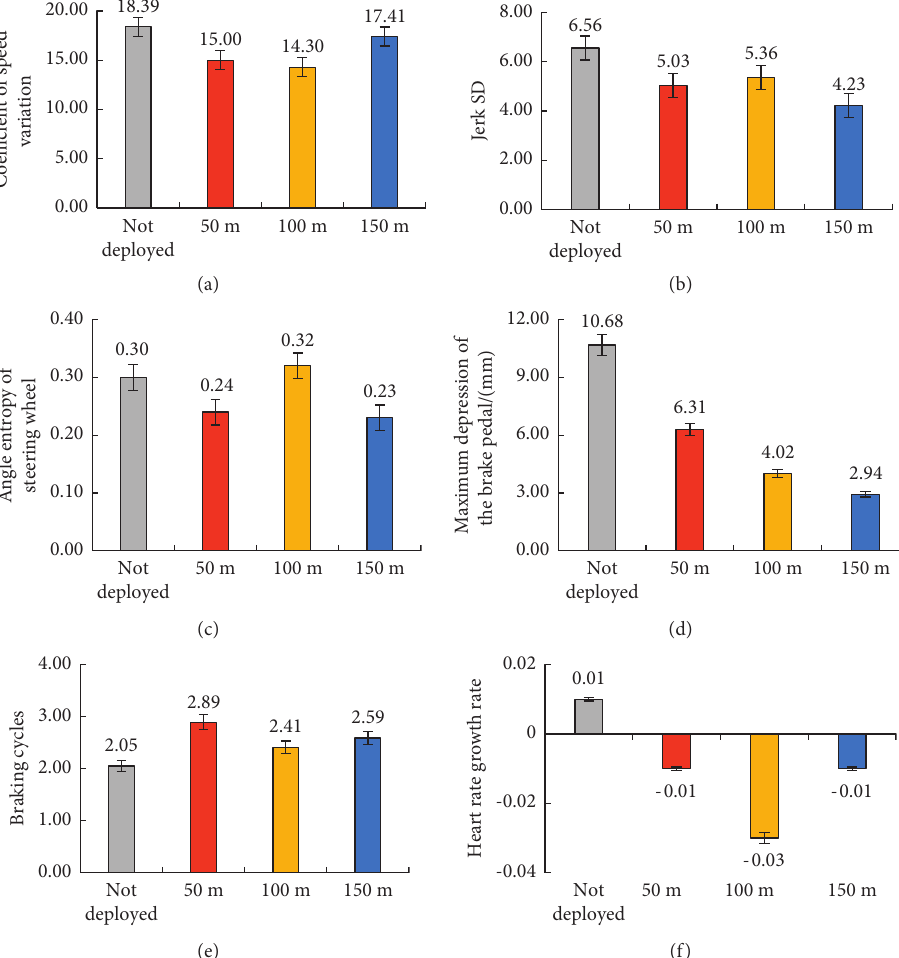
Figure 5: The indexes of three schemes. (a) Coefficient of speed variation. (b) Jerk SD. (c) Angle entropy of steering wheel. (d) Maximum depression of the brake pedal. (e) Braking cycles. (f) Heart rate growth